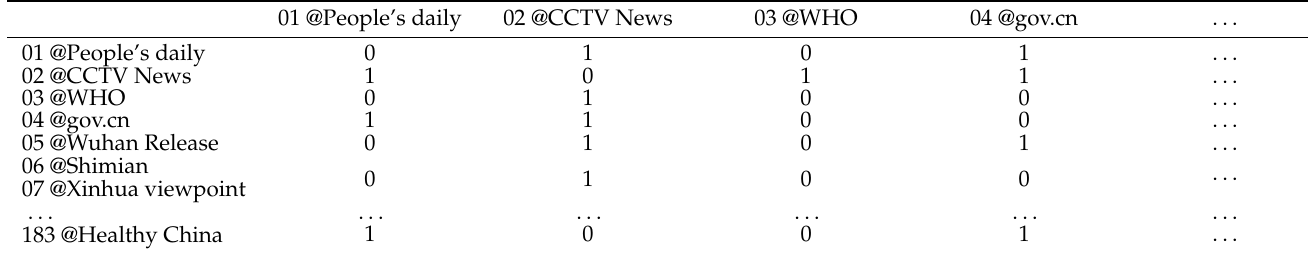
Table 3. Relationship matrix of the 183 Weibo key influencer